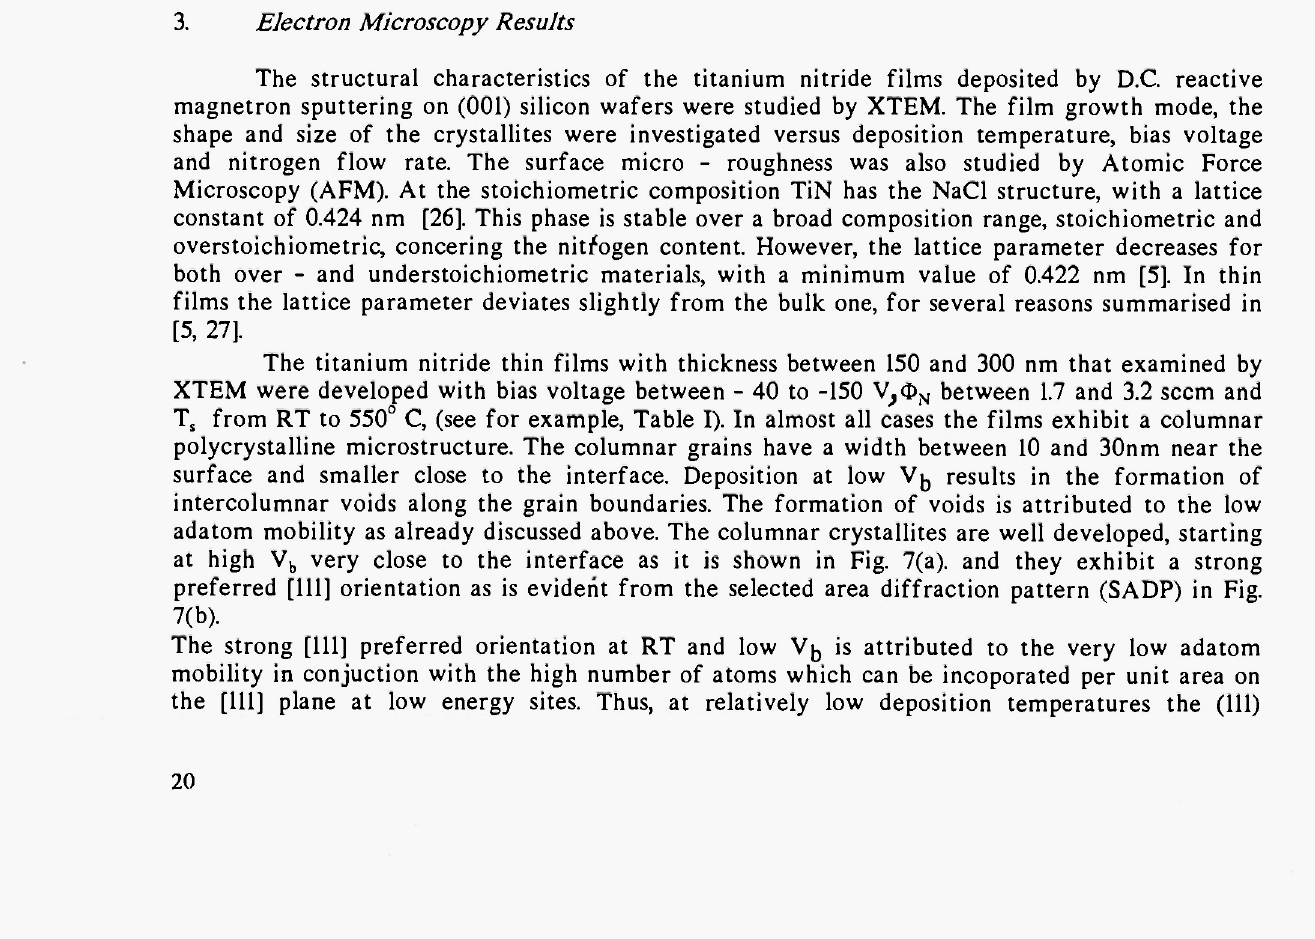
Fig.5 The dependence of stoichiometry in TiN films on V as deduced by b